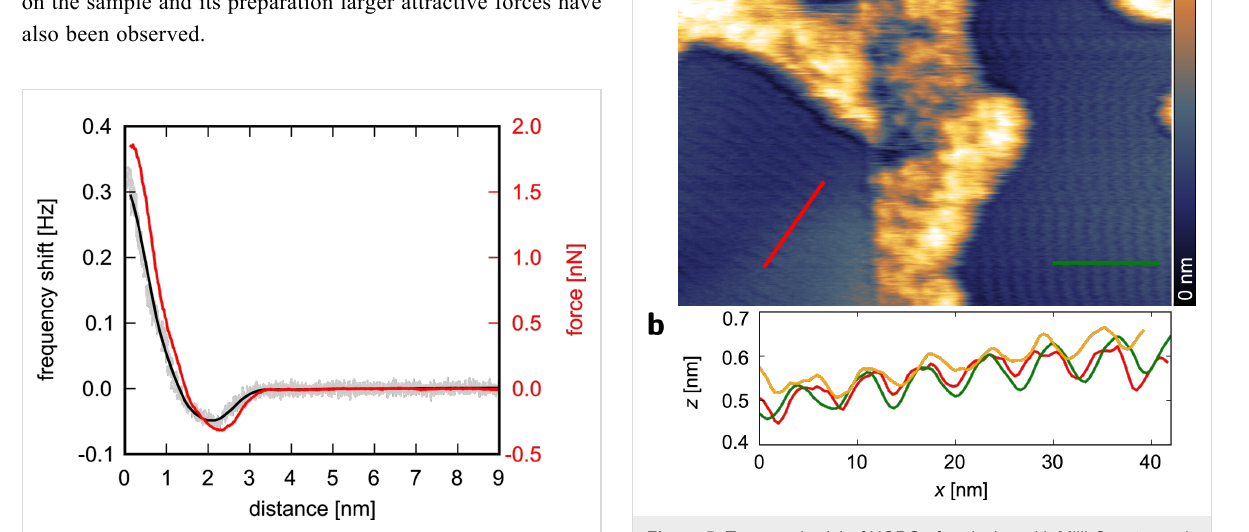
Figure 5: Topography (a) of HOPG after rinsing with Milli-Q water and height profiles (b) along the lines indicated in a) showing the periodic patterns of three domains. A = 1.1 nm, Δ f = +0.2 Hz, scan speed 977